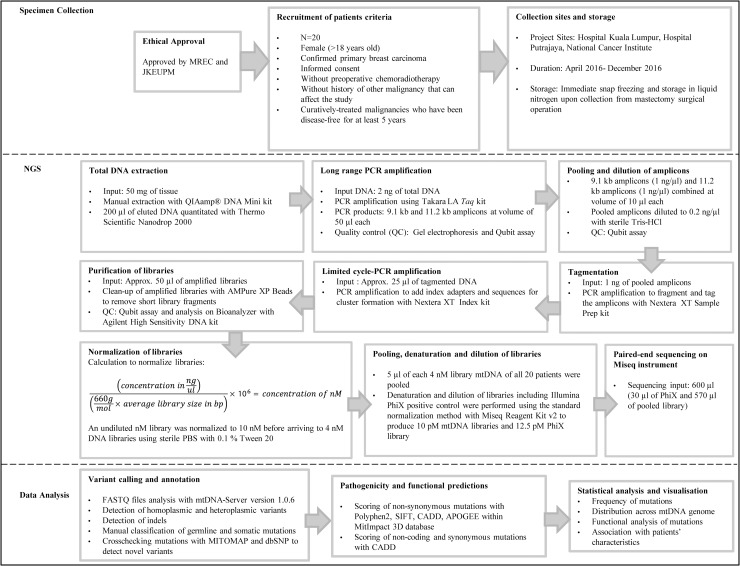
Flow chart describing the mtDNA mutation study.